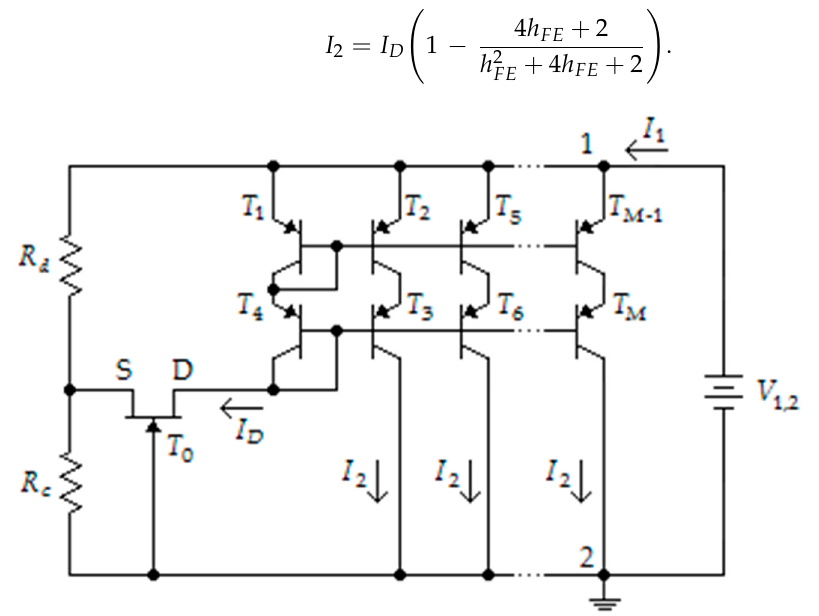
Figure 3. Two-terminal NDR circuit with multiple-output cascode current mirror.